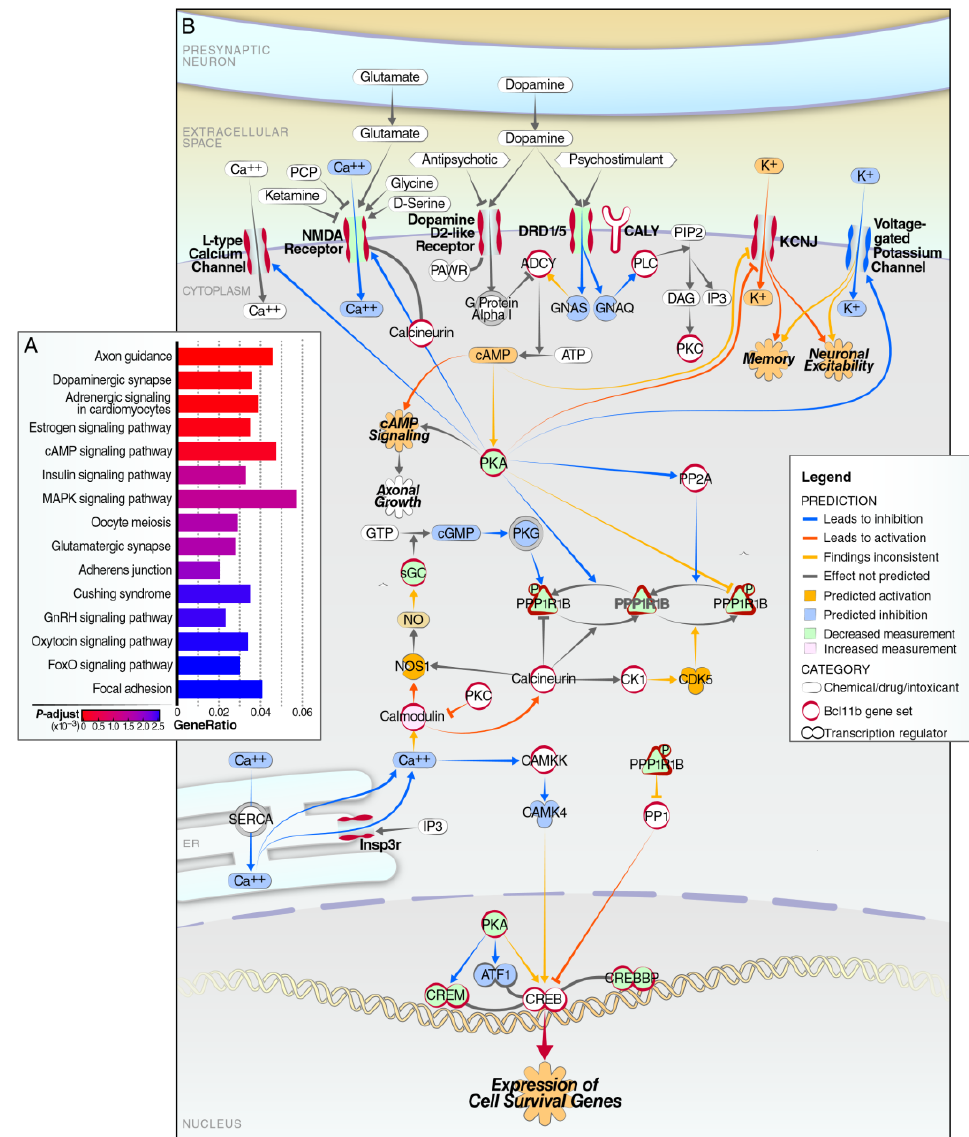
Figure 3. Significantly enriched KEGG terms and IPA signaling. ( A ) KEGG term enrichment analysis of gene signatures altered by Bcl11b deletion highlighted the axon guidance, dopaminergic synapses, adrenergic, estrogen, cAMP, MAPK, insulin, oocytes, and glutamatergic signaling. ( B ) IPA signaling pathway highlights for dopamine DARPP-32 feedback cAMP signaling.